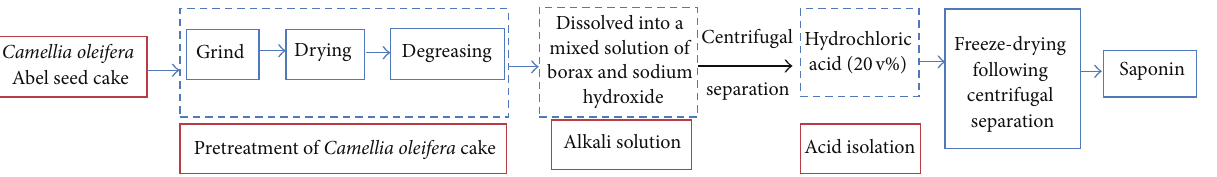
Figure 1: The flowchart of the extraction process of